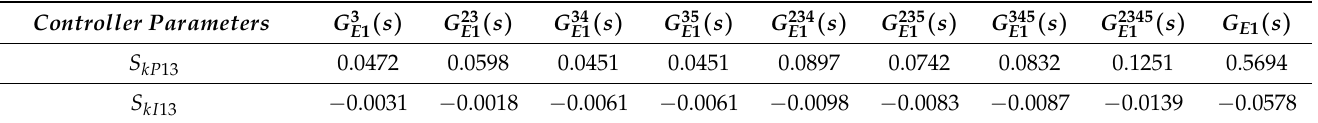
Table 3. The sensitivity of different paths of the en-stabilizing functions to the parameters of DC